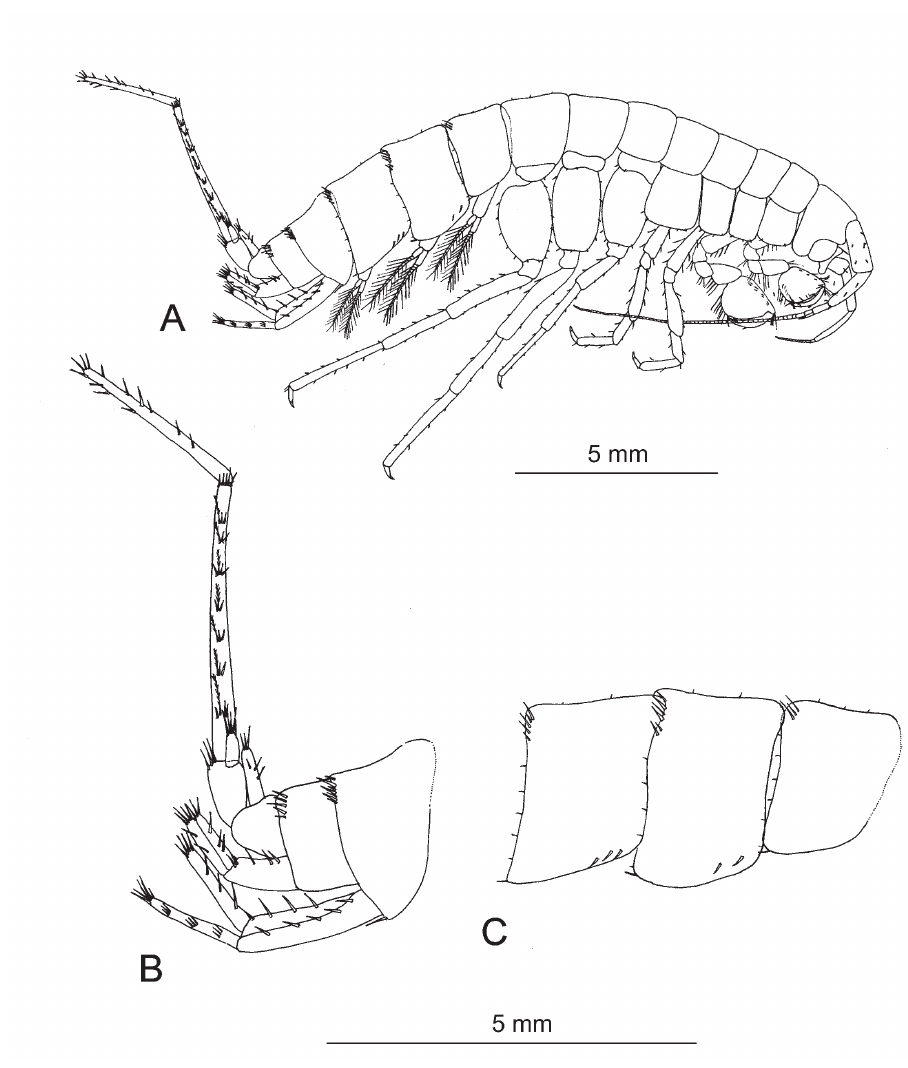
Figures 6. Niphargus enslini , male from the Blätterteighöhle A habitus B urosomites and uropods C epimeral